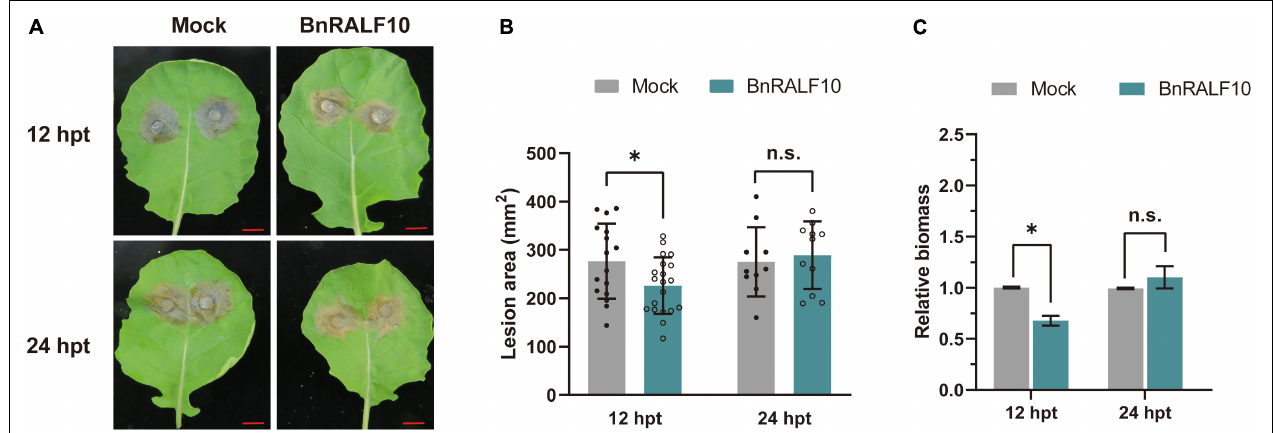
FIGURE 5 | BnRALF10 peptide induced plant resistance to S. sclerotiorum . Representative disease symptoms (A) , lesion area (B) and fungal biomass statistical analysis (C) of oilseed rape leaves pretreated with 1 µ M BnRALF10 peptide solution or ddH 2 O (Mock) at 12 h and 24 h post inoculation with S. sclerotiorum . Scale: 1 cm. Data are shown as the mean ± SE. The asterisks indicate significant differences from the control, as determined by one-way ANOVA ( n = 7 leaves, n.s., not significant, ∗ P ≤ 0.05). The experiments were repeated three times with similar results.